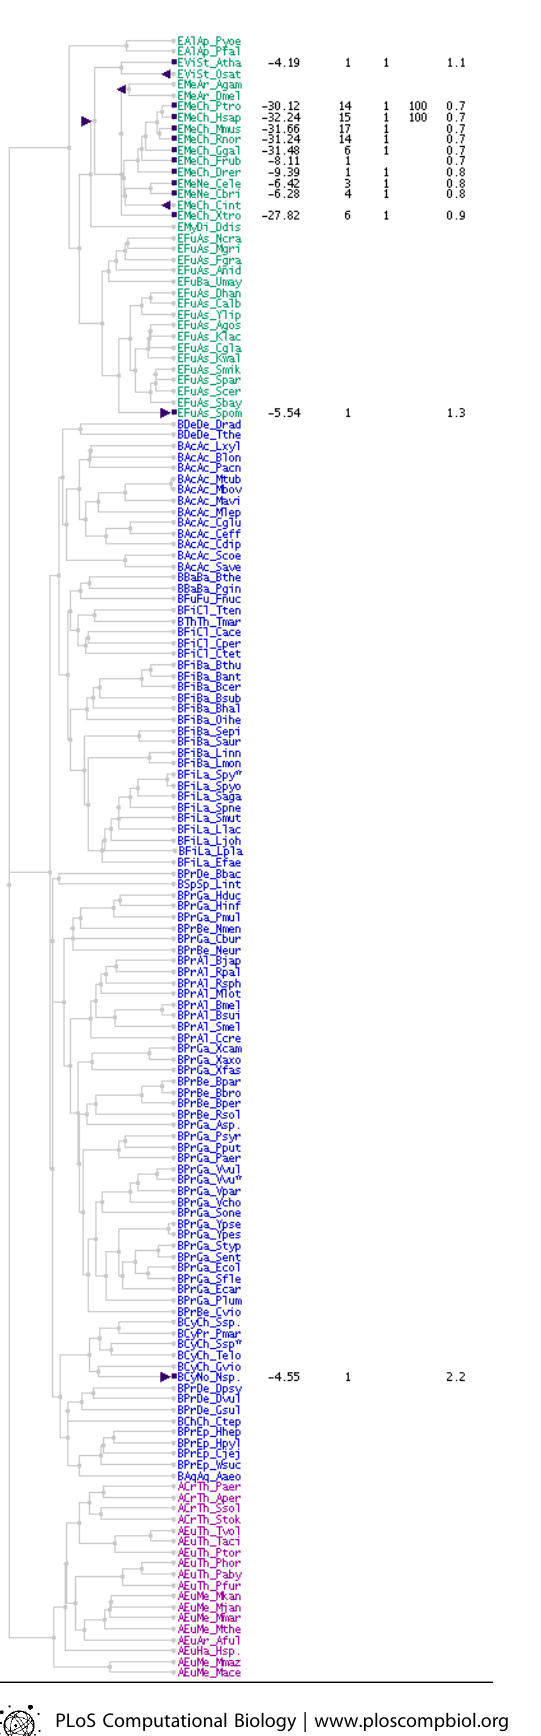
Figure 1. The Phylogeny, Including All 150 Genomes, Showing the Occurrence Pattern for Superfamily a.126.1 (Serum Albumin-Like) for SUPERFAMILY Data Losses (left-pointing triangles) and gains (right-pointing triangles) are shown as calculated by the parsimony algorithm. The assignments with a gain at leaf level are isolated within the tree. For each occurrence the log10 e-value (log(ev)), the number of copies (copy), consensus with PSI- BLAST occurrence (cons), and cluster distance (clust) are shown. The src column shows which genomes contain a source sequence for the superfamily by indicating the sequence identity to a SCOP domain.